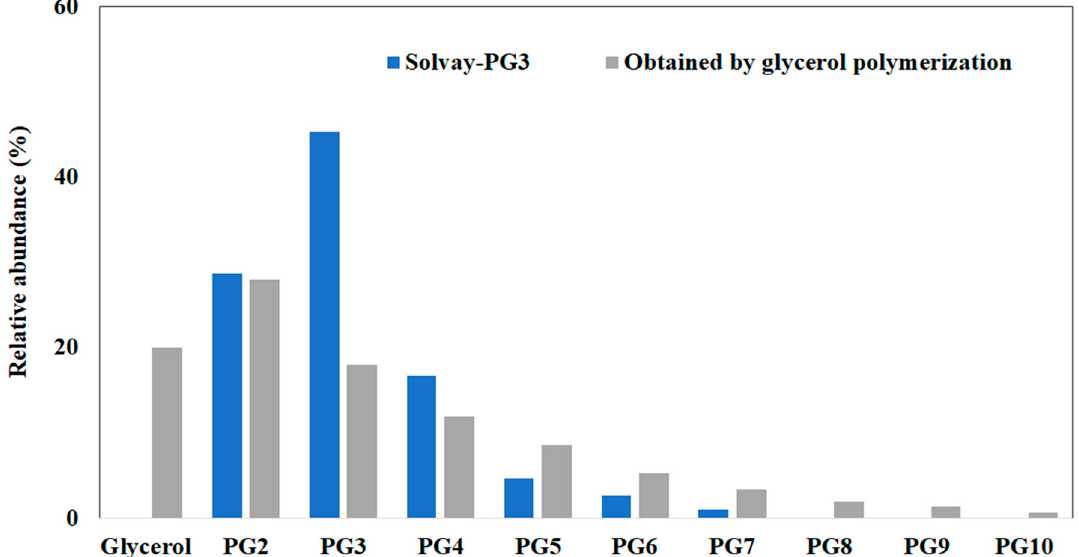
Figure 3. Comparison of polyglycerols distributions of Solvay-PG3 and polyglycerols obtained from catalytic polymerization of glycerol (average molecular weight = 250 Da) (reproduced from [38]).